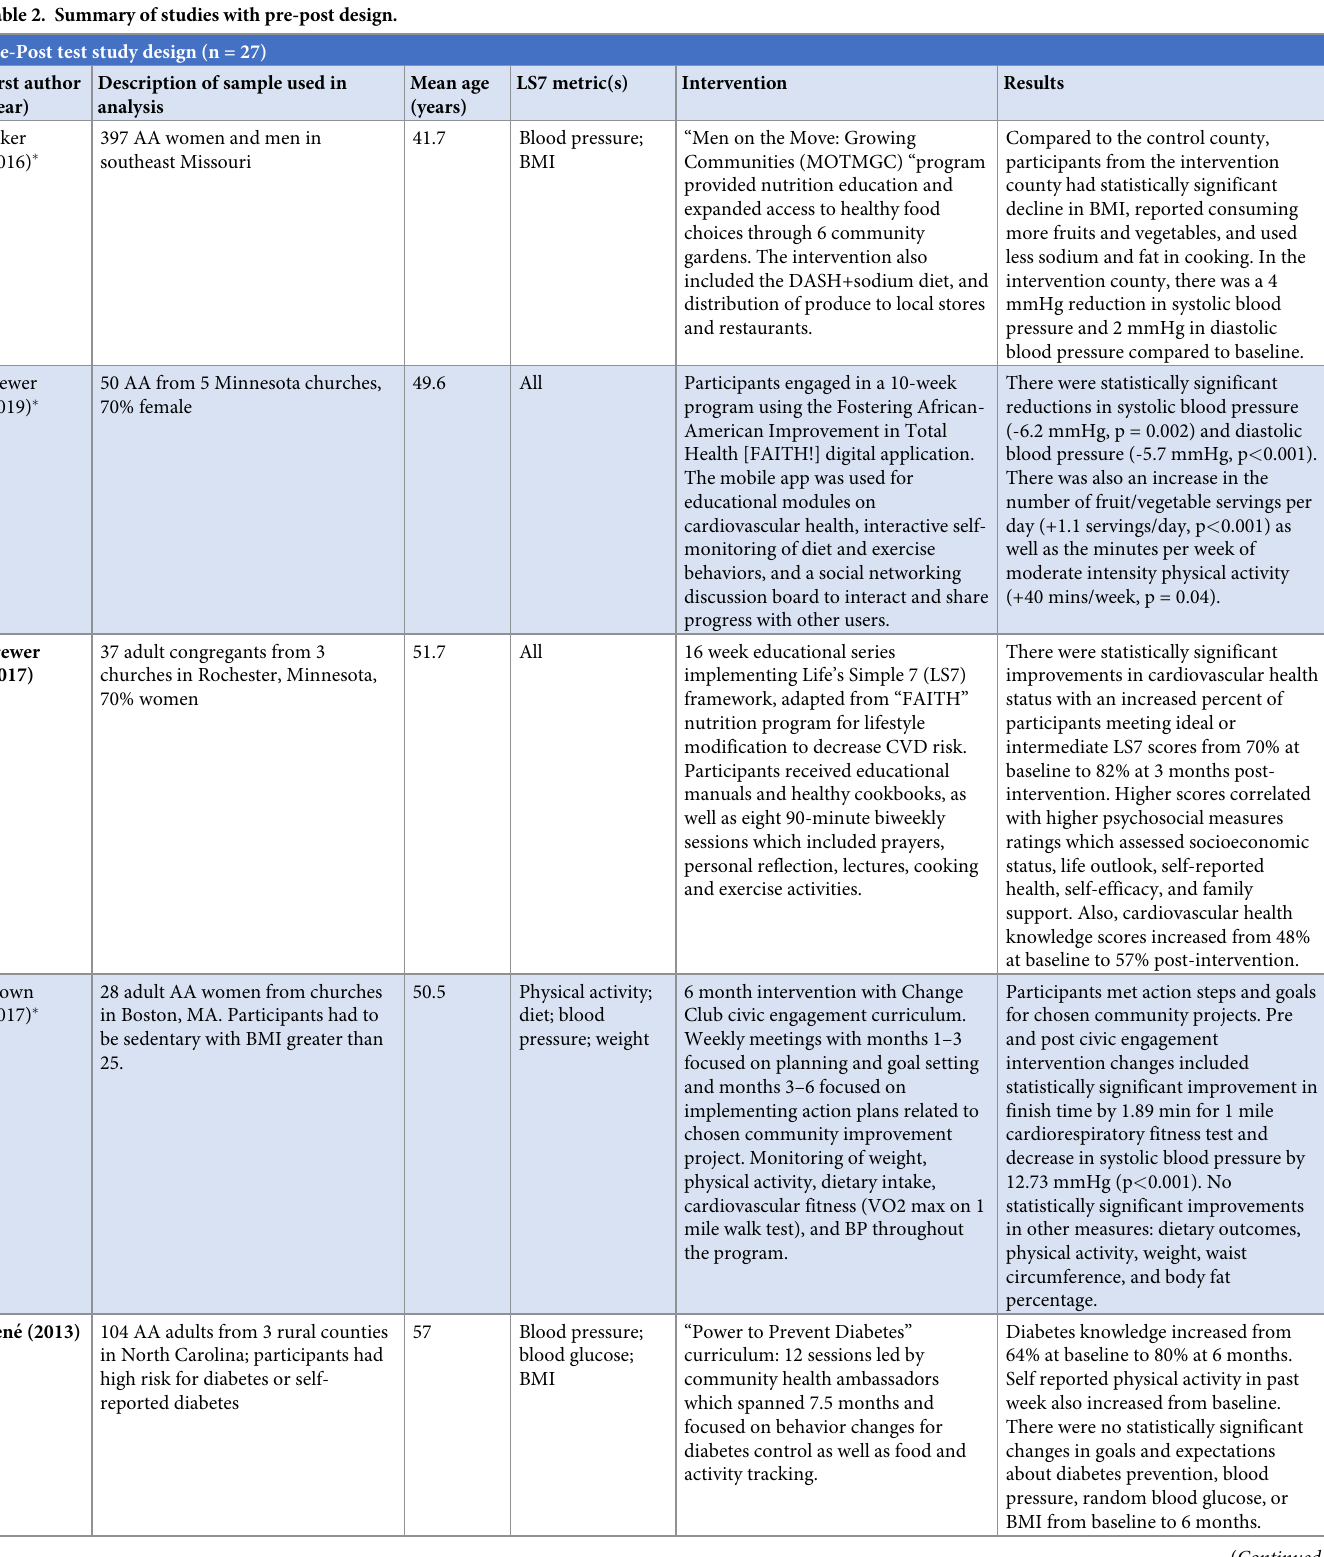
Table 2. Summary of studies with pre-post